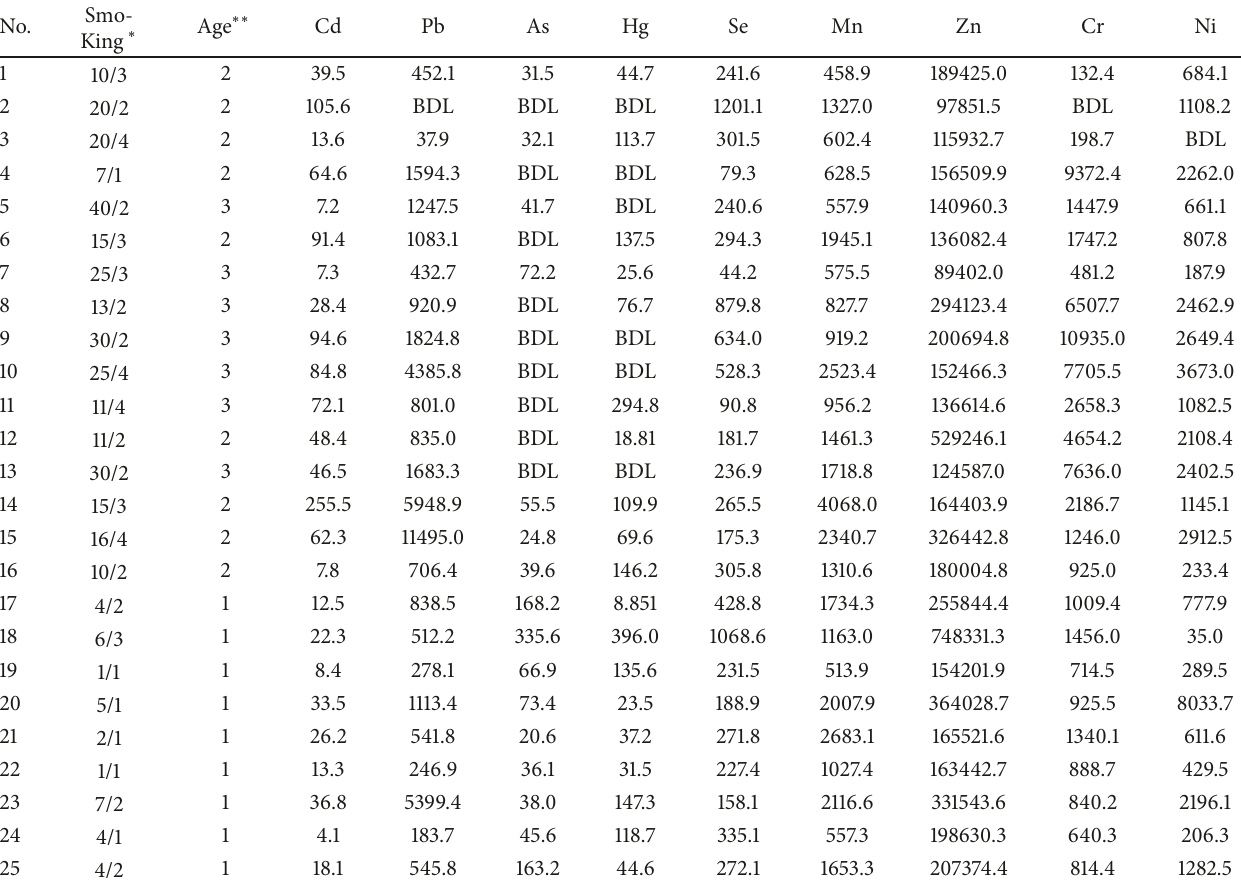
Table 6: Toxic elements levels in cigarettes smokers human hair ( 𝜇